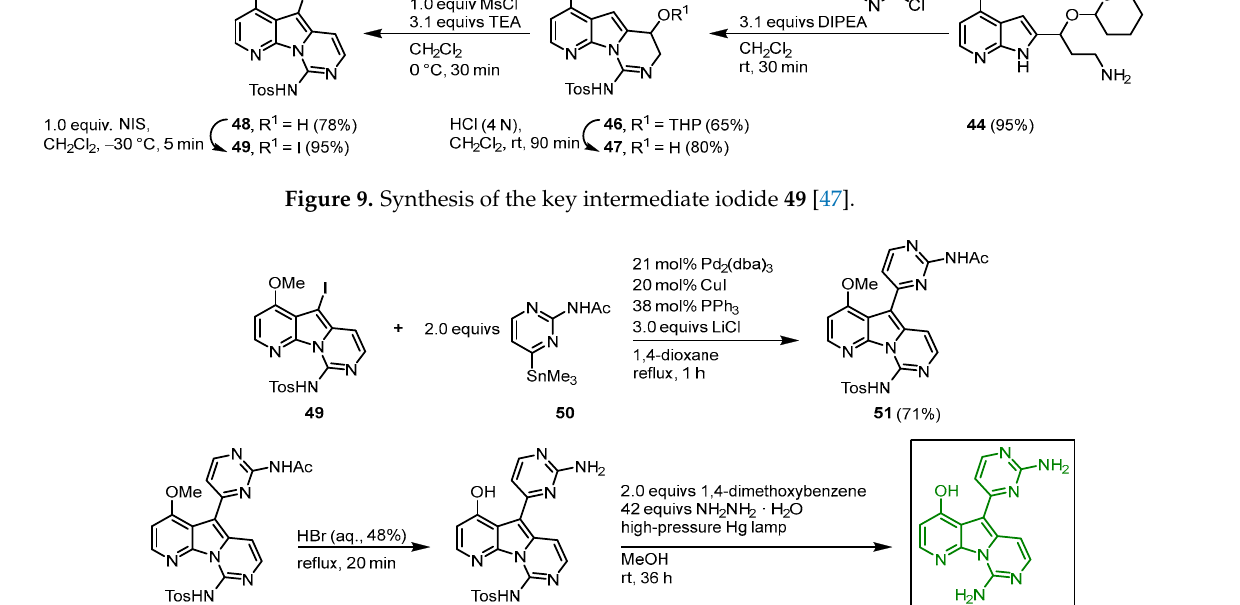
Figure 9. Synthesis of the key intermediate iodide 49 [47].